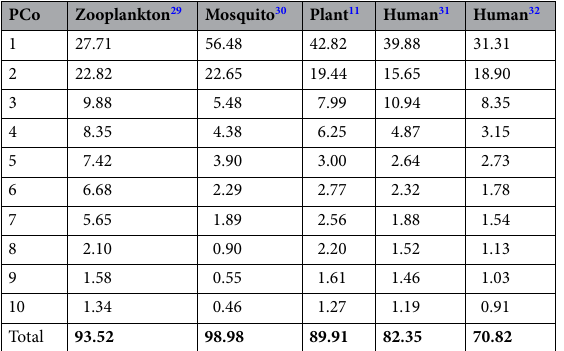
Table 2. Variance explained* by the first 10 Principal Coordinates (PCos). *Relative